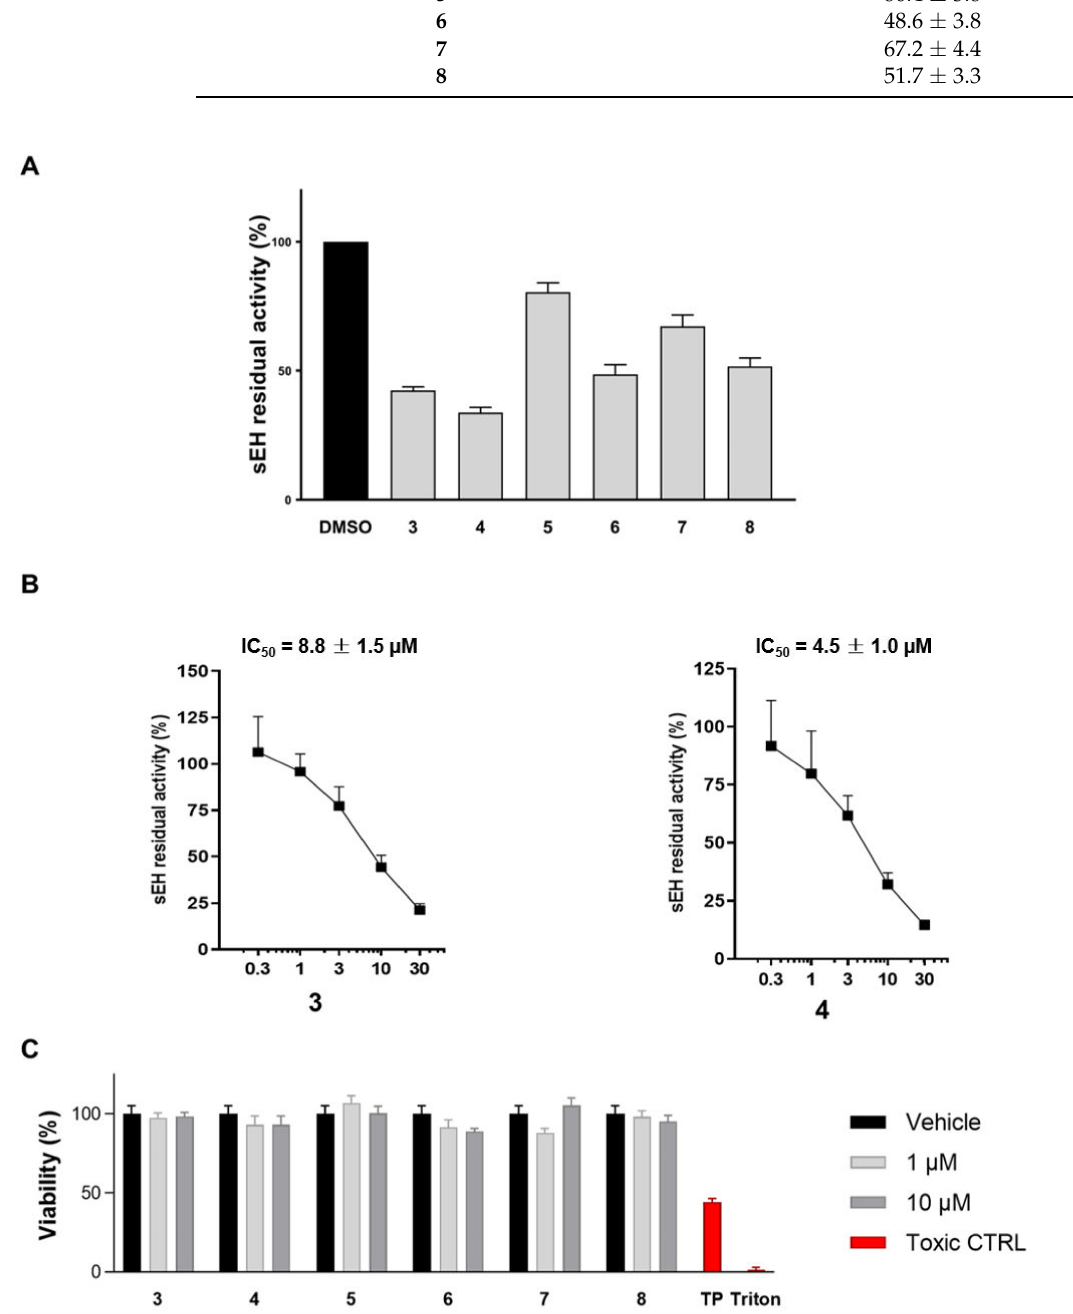
Figure 9. ( A ) sEH residual activity after treatment with compounds 3 – 8 at 10 µ M (DMSO is the positive control); ( B ) Concentration-response curve for sEH inhibition by compounds 3 and 4 . The enzyme was incubated for 15 min with compounds 3 and 4 at different concentrations (from 0.3 µ M up to 30 µ M) or vehicle (1% DMSO); ( C ) Cell viability assays for 3 – 8 on peripheral blood mononuclear cell